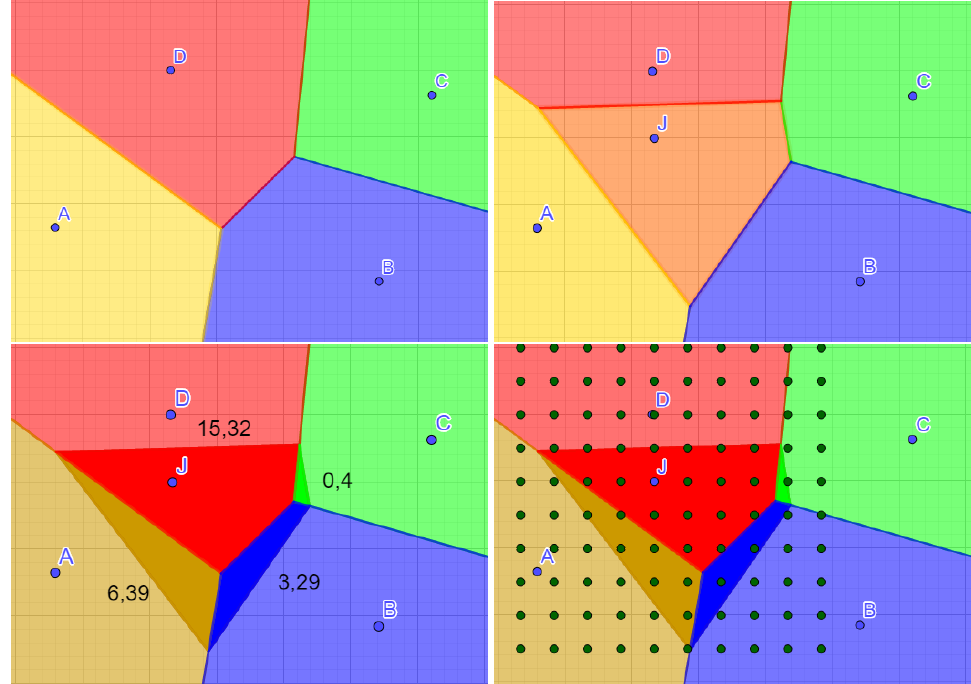
Figure 2. ( Top left ) original Voronoi diagram; ( top right ) updated Voronoi diagram with a new point; ( bottom left ) surface area portions taken by the new point; and ( bottom right ) sparse sampling of the affected part of the Voronoi diagram for estimating the surface area